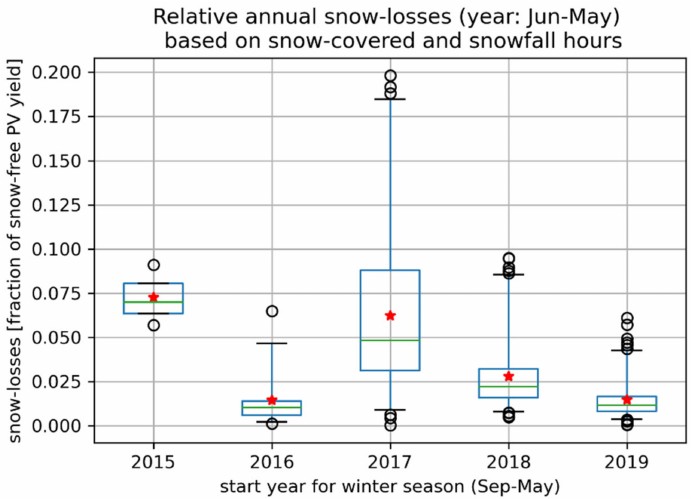
Figure 8. Boxplot for percentual snow losses per winter season for all 258 sites. The figure indicates mean (red star), median (green line), 50% (box), 95% (whiskers) intervals, and outliers (circles).